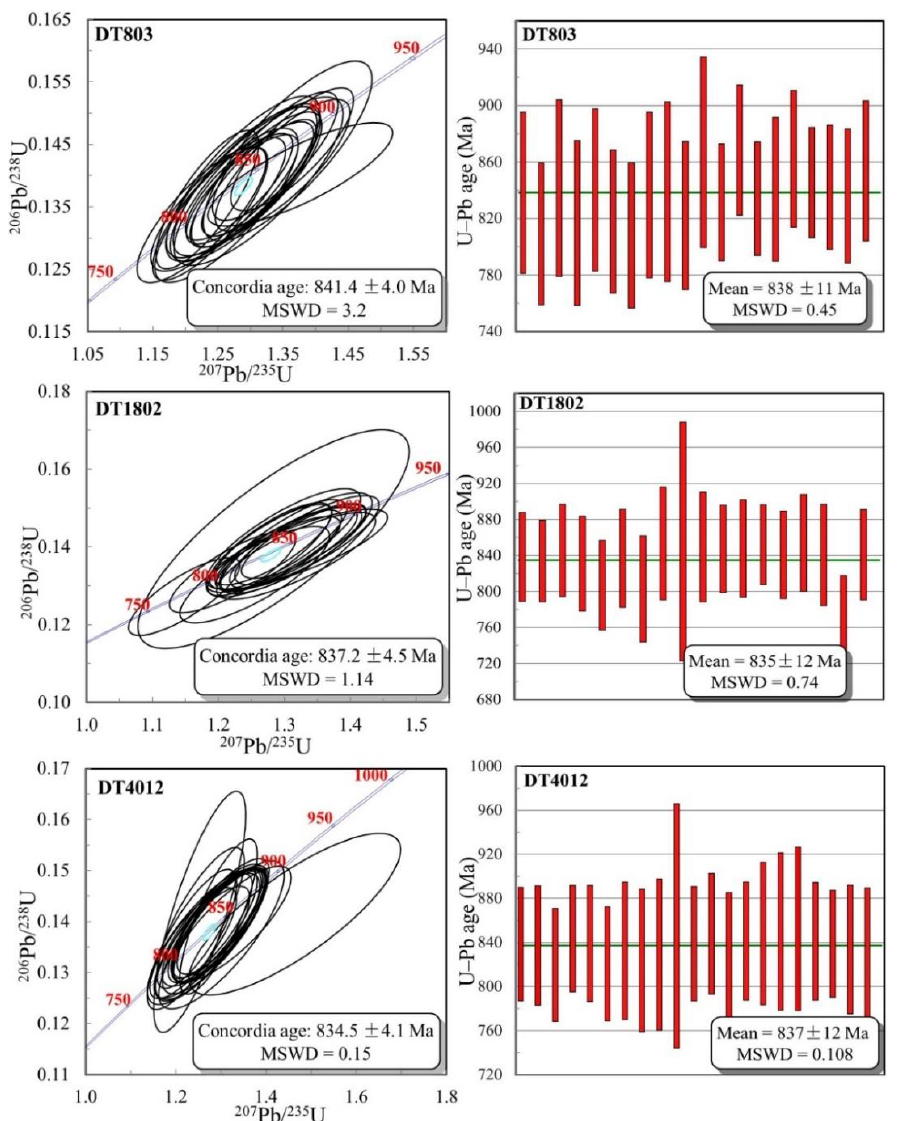
Figure 11. LA-ICP-MS U–Pb concordia diagram of the uraninite and weighted ages of samples DT803 (Ur1), DT1802 (Ur2), and DT4012 (Ur2) from the Datian uranium